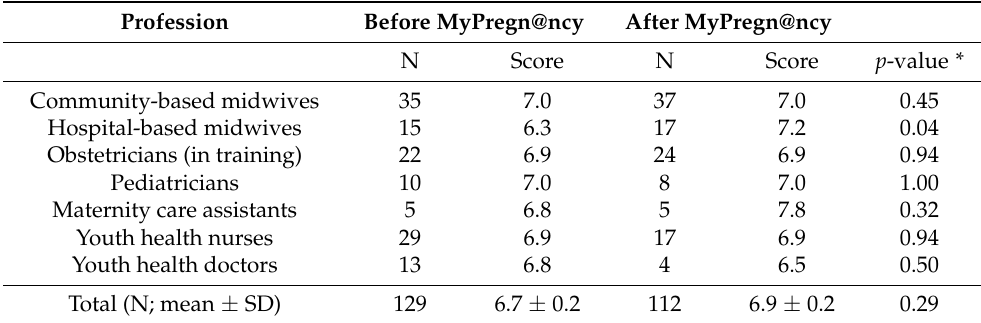
Table 3. Collaboration between health